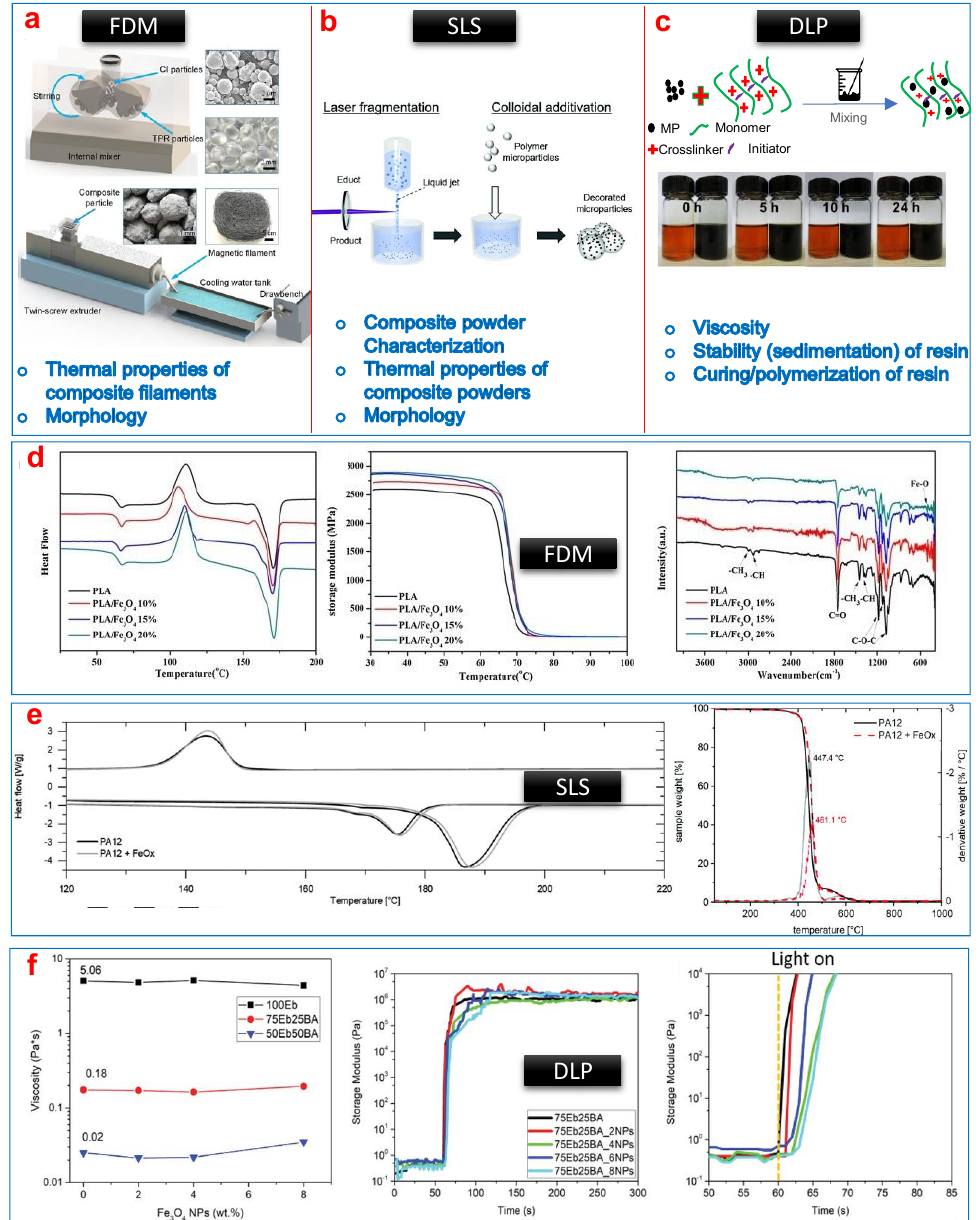
Figure 10. Material modification and requirement to develop magneto-active 4D structures via FDM, SLS, and SLA tech- niques. ( a ) Composite filament formation method (adapted from [253]), ( b ) composite powder formation method (adapted from [254]), ( c ) composite ink formation method (adapted from [256]), ( d ) examples of thermal and chemical properties of modified PLA-iron oxide composite filaments for FDM (adapted from [265]), ( e ) examples of thermal properties of modi- fied PA12-iron oxide composite powder for SLS (adapted from [254]), and ( f ) rheological properties of acrylate iron oxide composite ink for DLP (adapted from [255]).